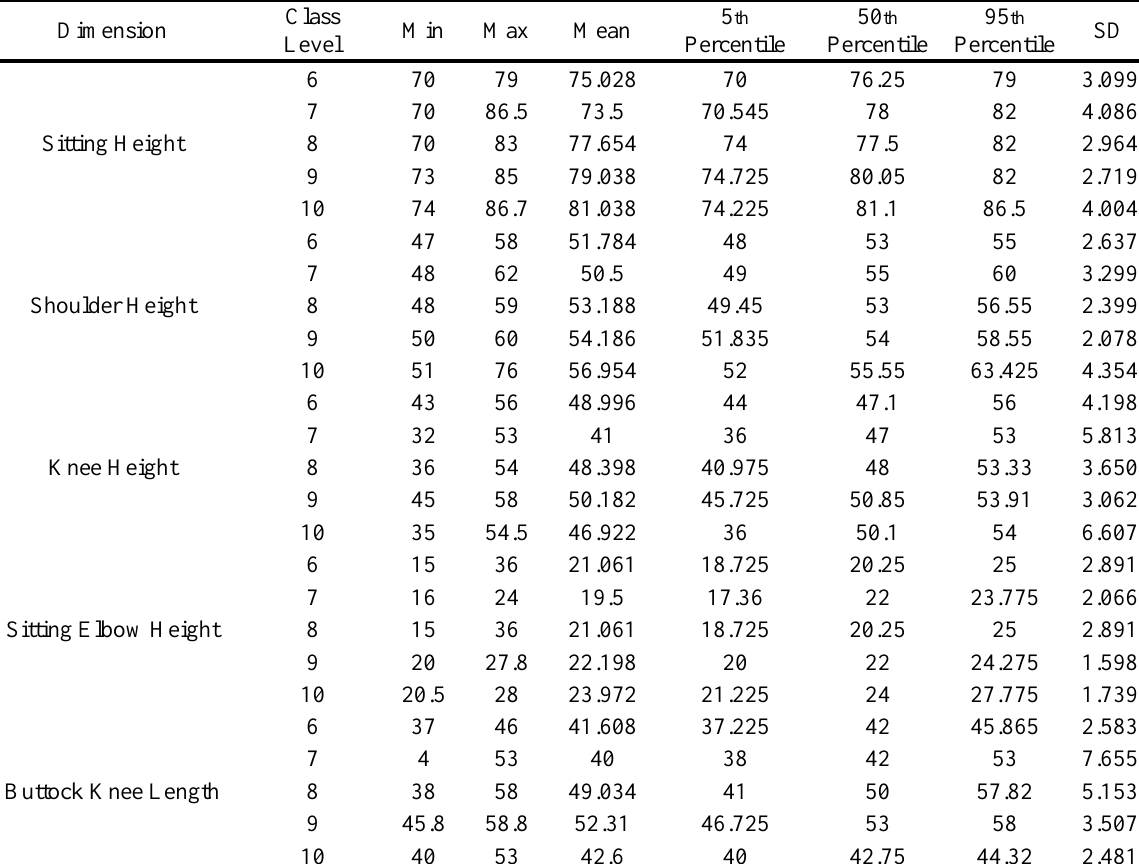
Table 2. Anthropometric measure (cm) of